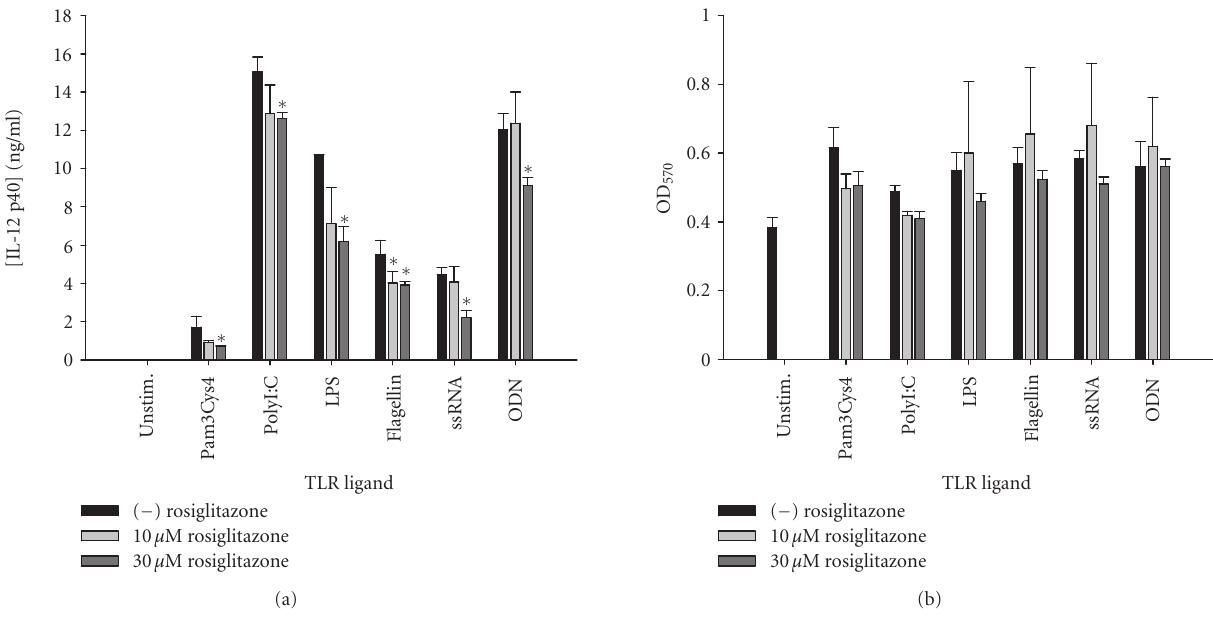
Figure 2: The synthetic PPAR- γ agonist rosiglitazone attenuates IL-12 p40 production in response to TLR ligands in microglia. Primary microglia were plated at 2 × 10 5 cells/well in 96-well plates and incubated overnight. The following day, cells were pretreated for 1hour with the indicated concentrations of rosiglitazone prior to the addition of TLR ligands. Cell-conditioned supernatants were collected at 24 hours following TLR ligand exposure, whereupon IL-12 p40 levels were determined by ELISA (a). The e ff ects of rosiglitazone on microglial viability were assessed using an MTT assay (b). Significant di ff erences between microglia treated with TLR ligands alone versus TLR ligands + rosiglitazone are noted with asterisks ( ∗ P < . 05). Results presented are representative of two independent